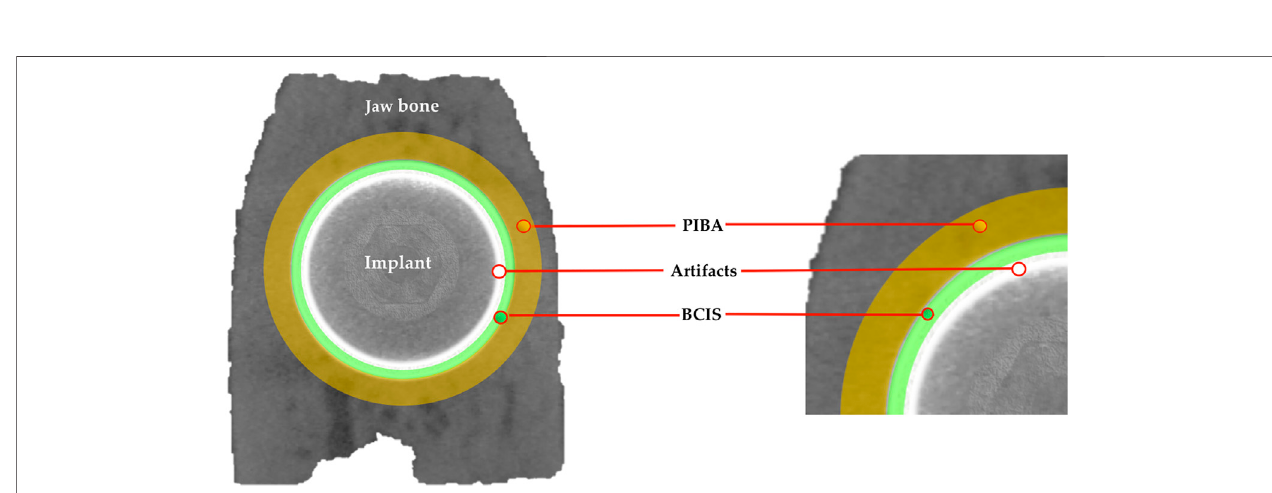
FIGURE 4 | Artifact area in white color; bone in contact with the implant surface (BCIS) in green color and peri-implant bone area (PIBA) in yellow color.